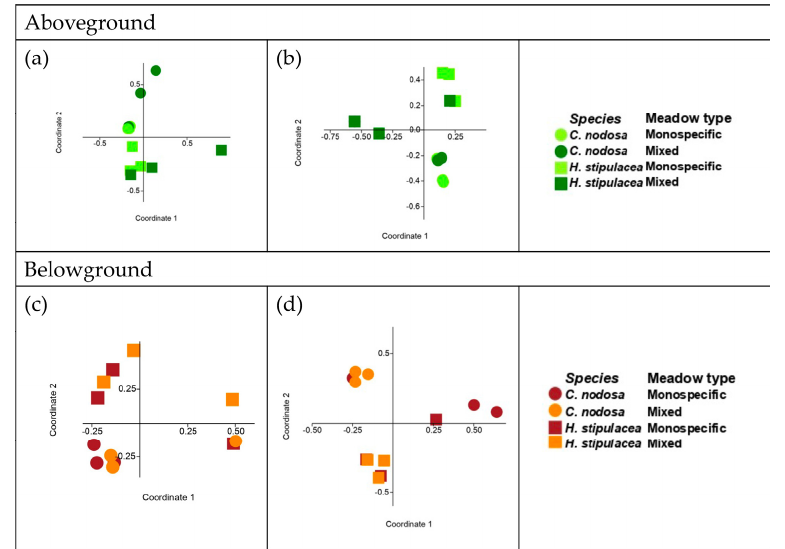
Figure 1. PCoA analysis with Bray ‐ Curtis dissimilarity matrix of the aboveground ‐ associated bacterial communities in site #1 ( a ) and #2 ( b ) and of the belowground ‐ associated bacterial communities in site #1 ( c ) and #2 ( d ).